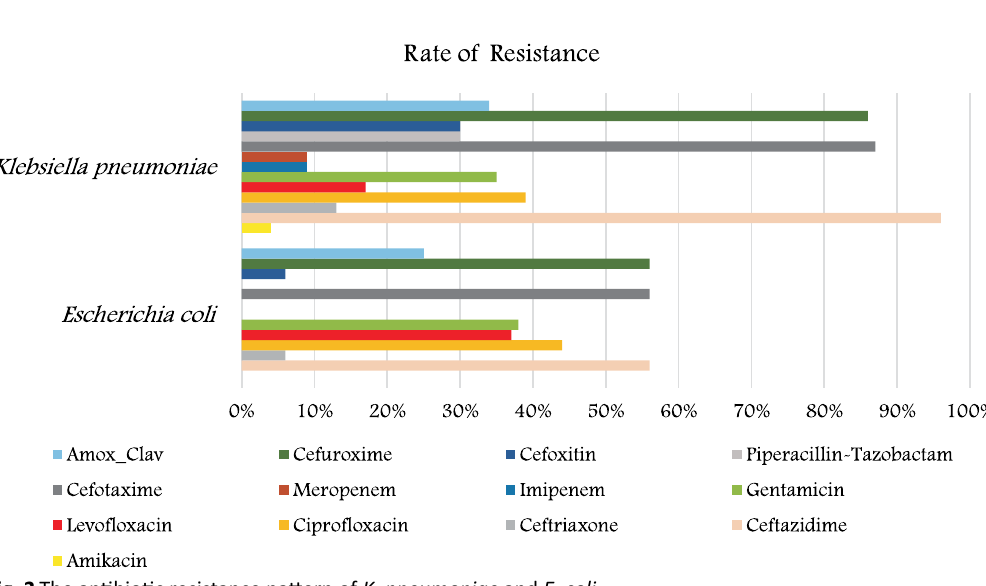
Fig. 2 .The antibiotic resistance pattern of K. pneumoniae and E. coli